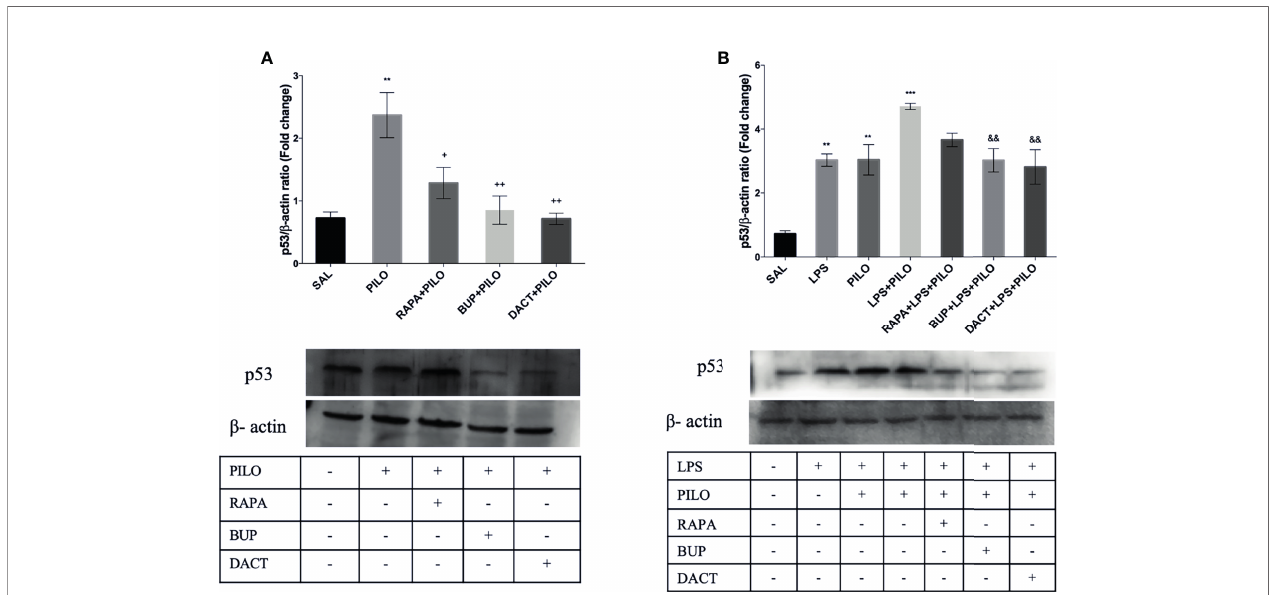
FIGURE 8 | RAPA, BUP, and DACT alter PI3K pathway p53 levels in mice hippocampus. The fi gure represents protein levels due to different treatments. (A) Levels of p53 in PILO and (B) levels of p53 in the LPS-primed PILO model. Treatment groups are indicated in the table against the band in the fi gure. Densitometry values for p53 were normalized to b -actin and expressed as fold change relative to the control group. The data are represented as mean ± SEM (n = 3) and analyzed by one-way ANOVA followed by Tukey Kramer multiple comparison tests. The signi fi cance is ascertained as ***p < 0.001 versus SAL, **p<0.01 versus SAL, && p<0.001 versus LPS+PILO, ++ p<0.01 versus PILO, and + p<0.05 versus PILO.